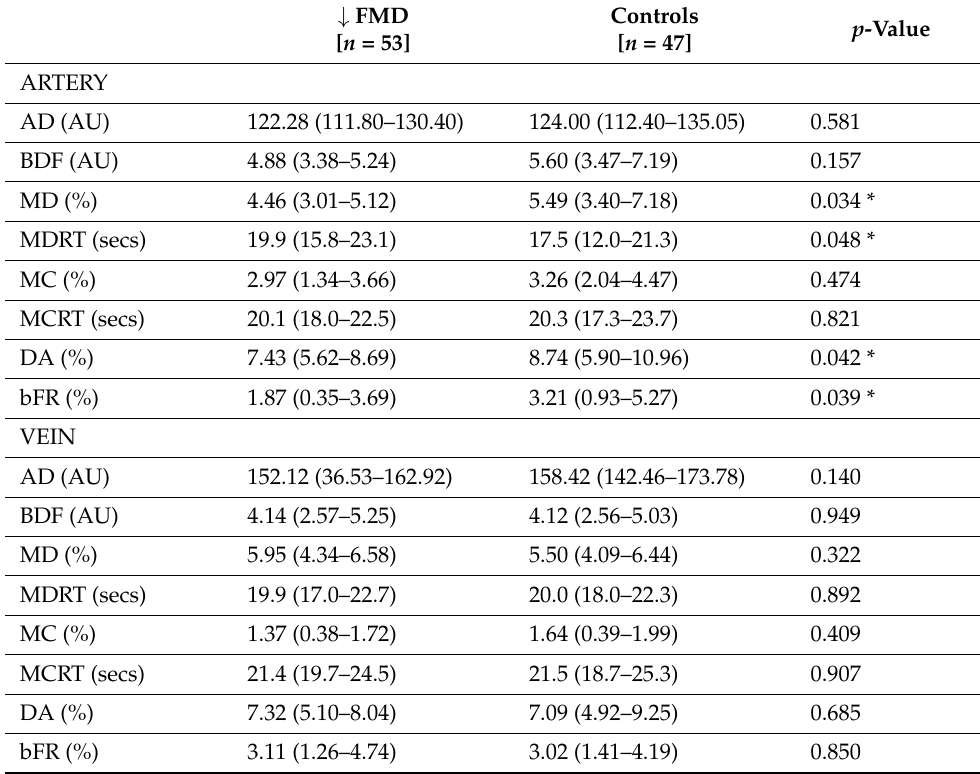
Table 3. Average Retinal Arterial and Venous Measures for Both Groups.